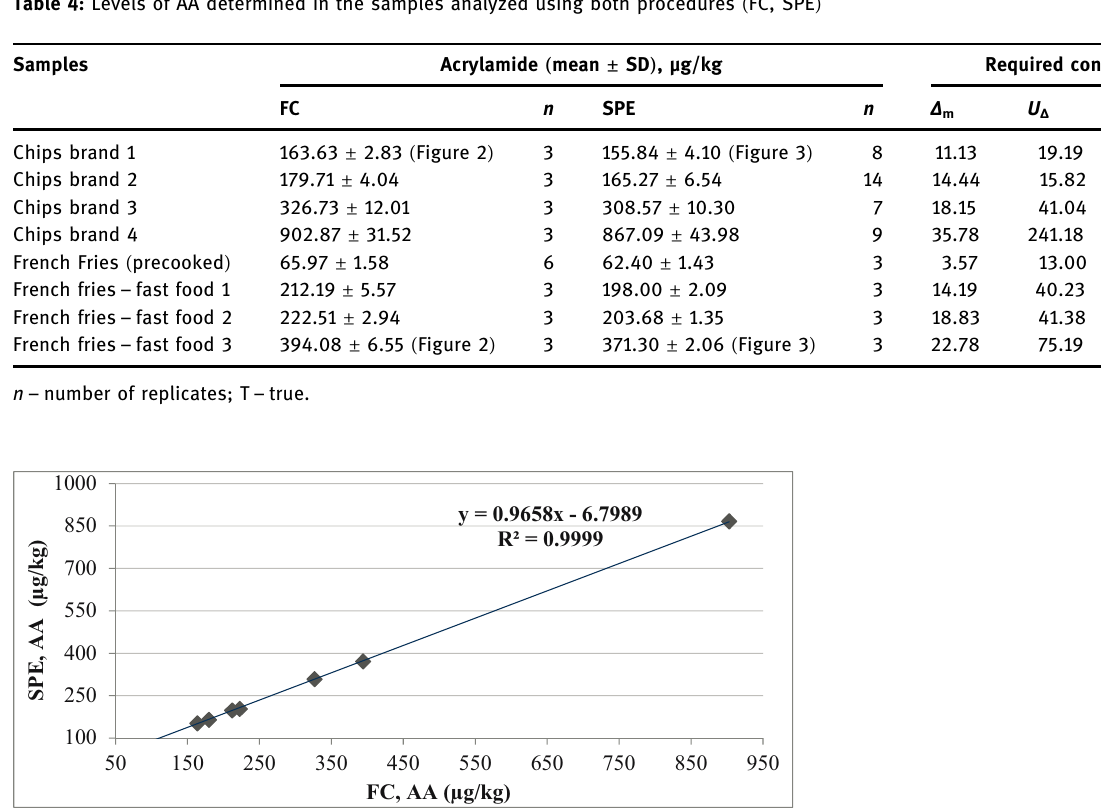
Table 4: Levels of AA determined in the samples analyzed using both procedures ( FC, SPE )